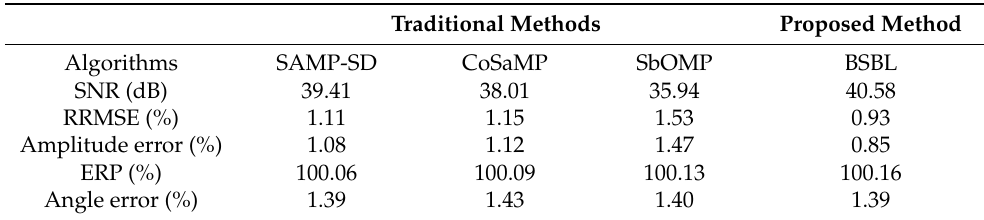
Table 6. Performance comparison of reconstruction algorithms (the harmonic